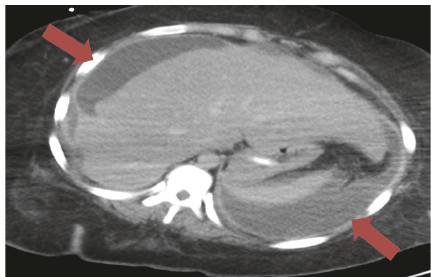
Figure 2: Patient’s computed tomography (CT) scan of the abdomen and pelvis after her two surgeries looking for collections that remained. Red arrows demonstrate complex perihepatic and perisplenic ascites with peritoneal enhancement concerning for postoperative purulent collections. The collections were subsequently drained percutaneously and found to represent